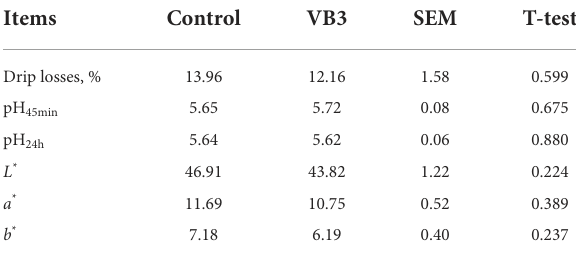
TABLE 3 Effects of dietary supplementation of niacin on carcass traits of Ningxiang pigs a .